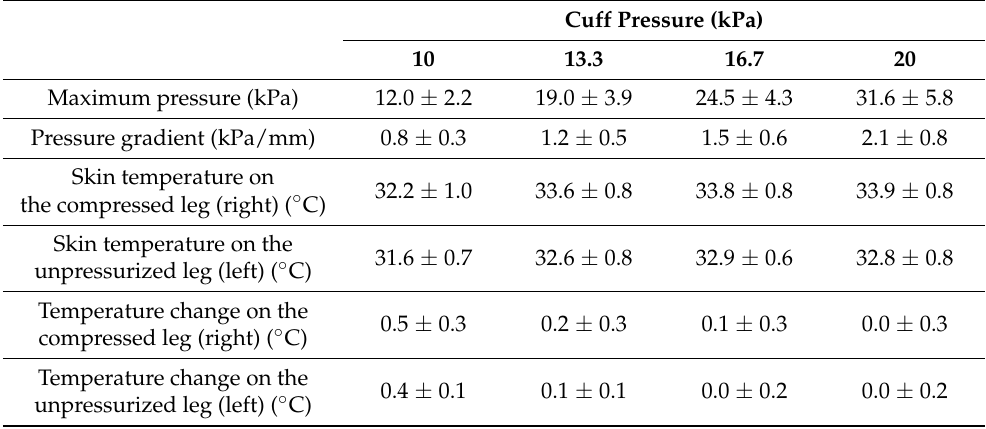
Table 3. Mean ± SD of measured values according to the cuff